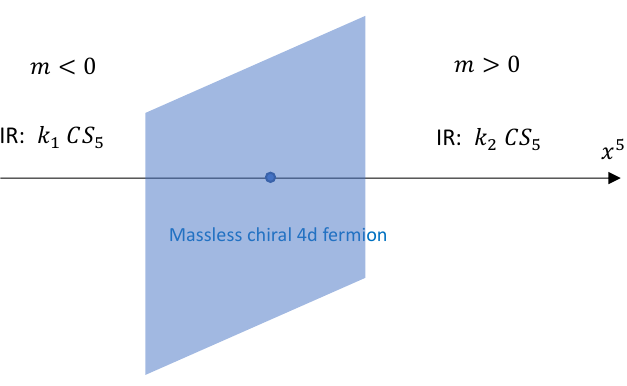
Figure 12 . 5d Chern-Simons term from a massive fermion in representation R is given by the anomaly of a 4d chiral fermion in the same representation by anomaly inflow: k